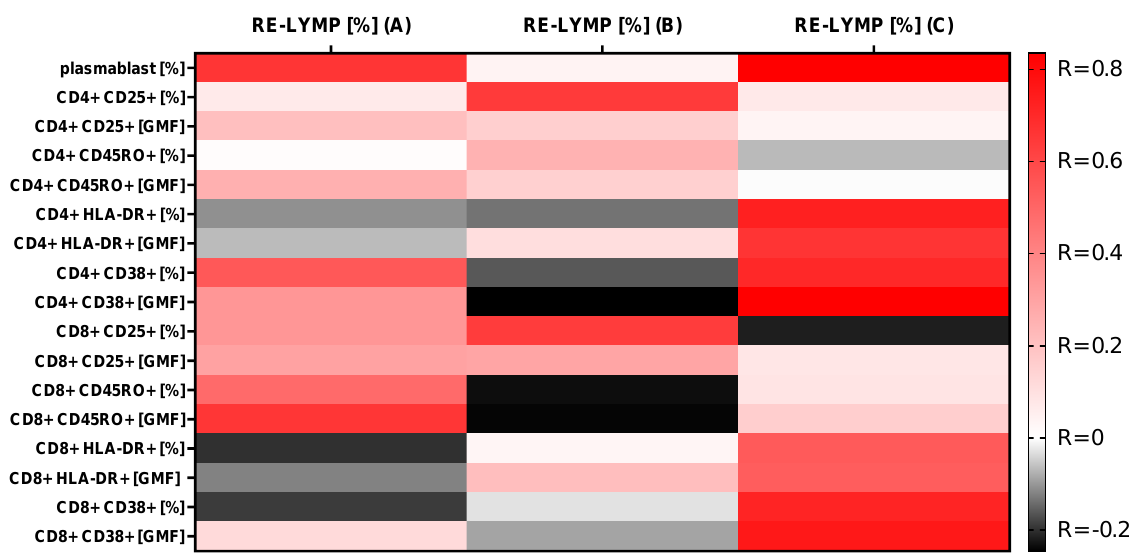
Figure 2. A heatmap of Spearman correlation coefficients for the RE-LYMP parameter with activation lymphocytes markers using multiparameter flow cytometry in the 3 groups. A. with positive COVID-19 test, B. control group (HC), C. group with other virus infections with negative COVID-19 test. Correlations with an absolute value more than 0.5 are associated with p < 0.05, red—positive correlations, black—negative correlations.